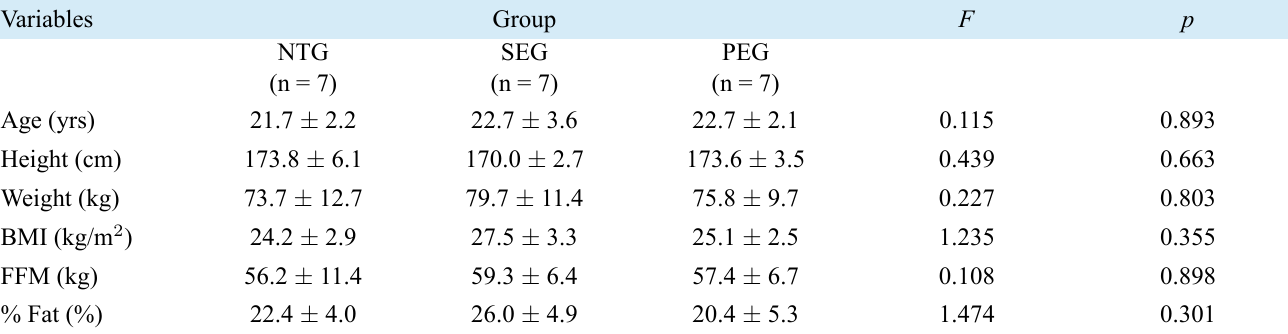
TABLE 1. Characteristics of participants.